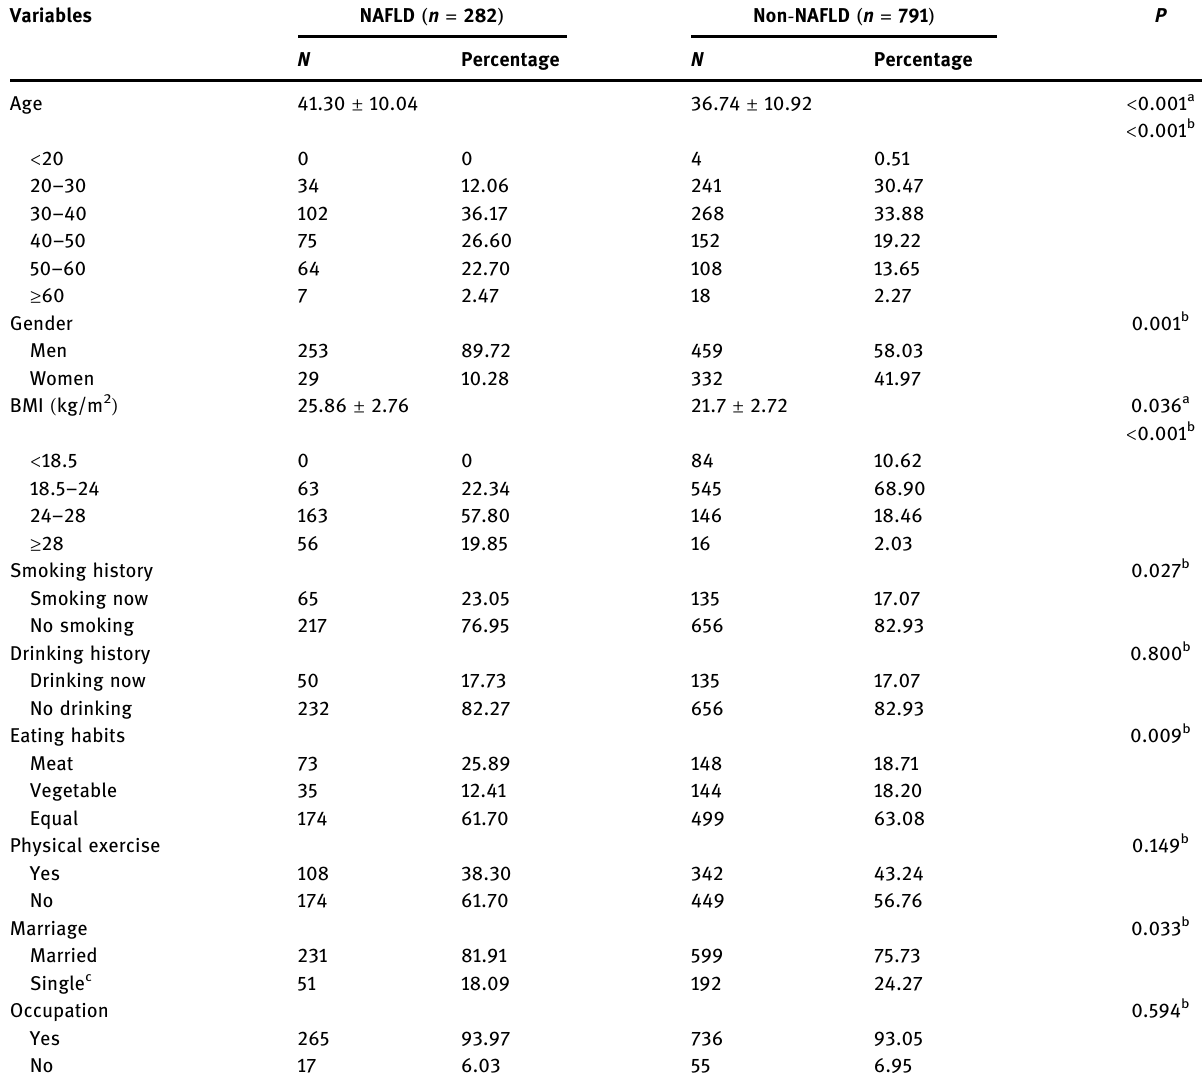
Table 1: Comparison of the general demographic of participants Variables NAFLD ( n = 282